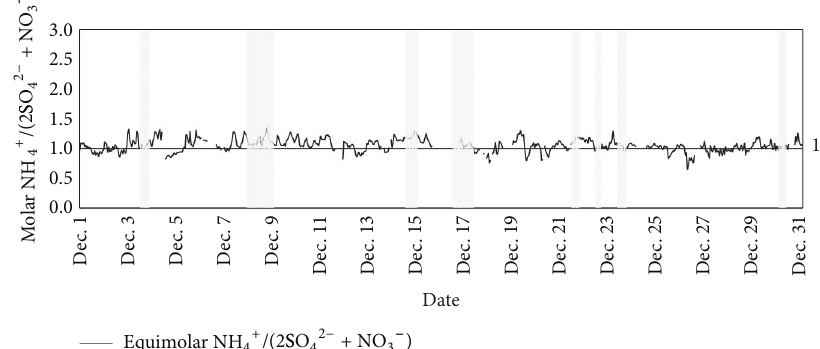
Figure 4: Time series of the molar equivalent ratio [ NH 4+ ] / ([ SO 42− ] + [NO 3− ]) during the study period.